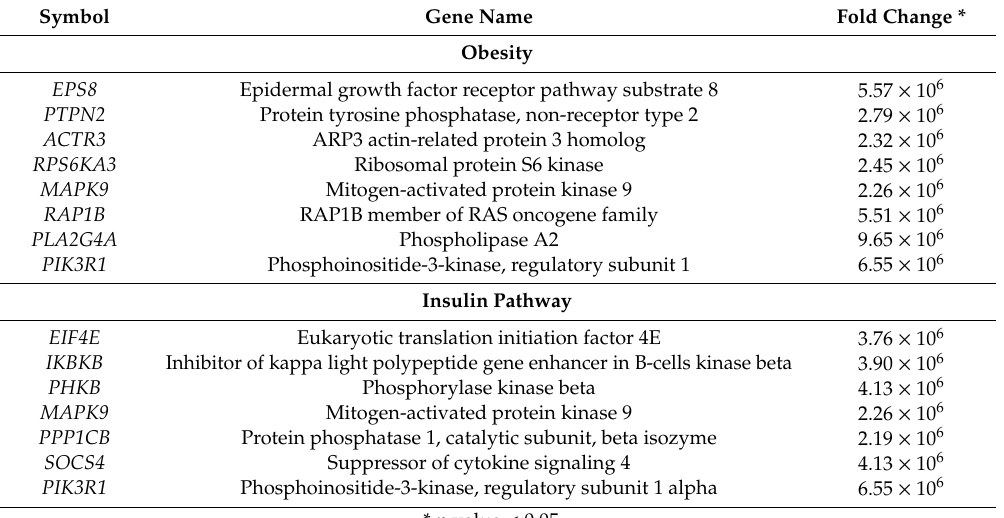
Table 2. Upregulated genes after six months of RYGB that are involved in the onset of obesity and insulin pathway ( p -value < 0.05). The fold change results were derived from the microarray assay.